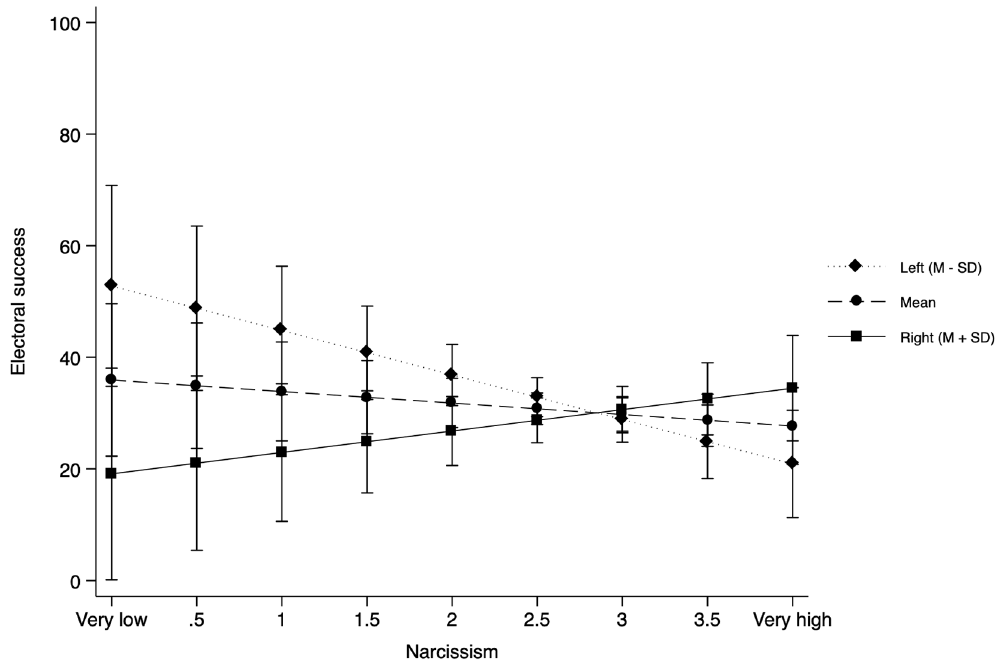
Figure 5. Electoral success by left-right * Narcissism; marginal effects. Note. Marginal effects with 95% CI, based on coefficients in Table 5 (model M2). All other variables fixed at their mean. The three groups represent three critical values for left-right, respectively at the mean value, one standard deviation below the mean value (left), and one standard deviation above the mean value